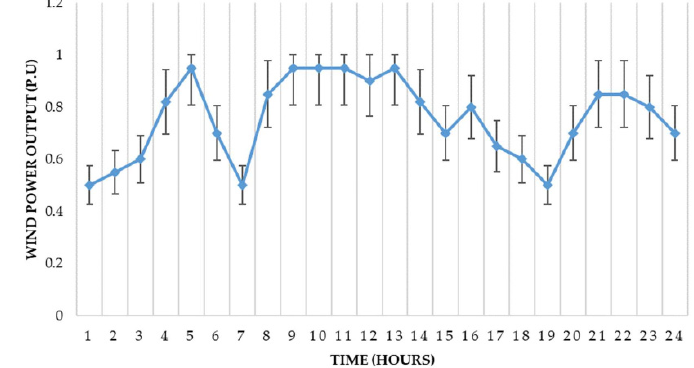
Figure 3. The selling/buying price in the DA market.